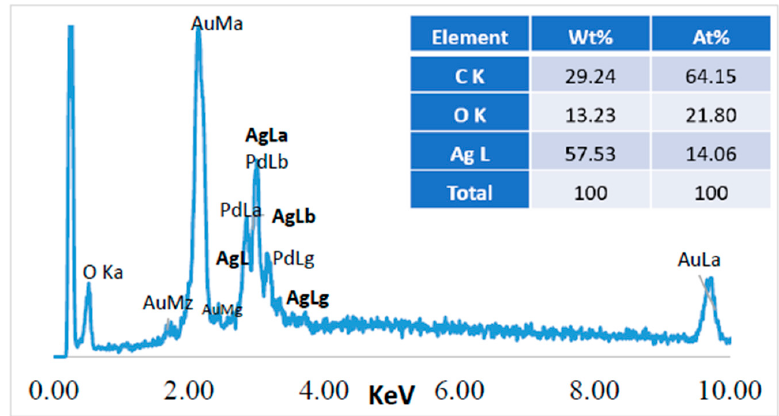
Figure 8. Chemical microanalysis of the jute fabric surface with Ag NPs (sample JPG3), EDS spectrum, and elemental composition.